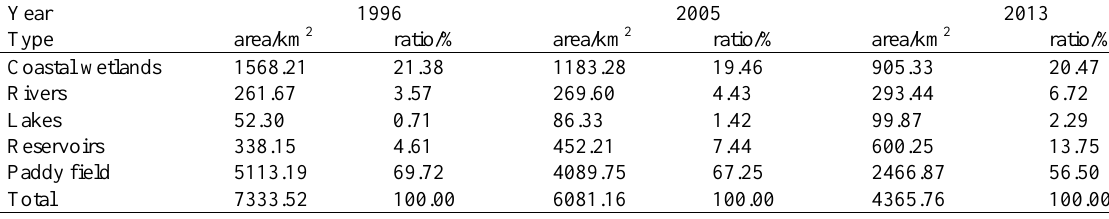
Table 3 The area (km 2 ) and ratio (%) of various of wetlands from 1996 to